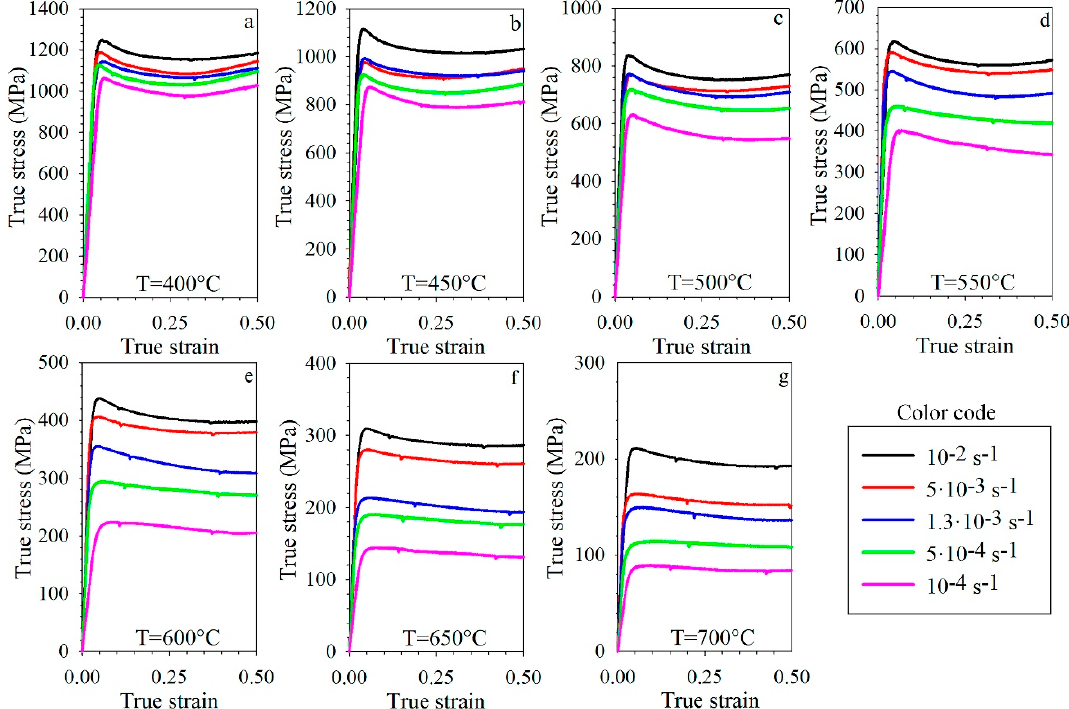
Figure 1. Compression curves of as-quenched Fe-0.36wt.%C-1wt.%Cr steel at temperatures of 400 ( a ), 450 ( b ), 500 ( c ), 550 ( d ), 600 ( e ), 650 ( f ) and 700 °C ( g ), and different strain rates.